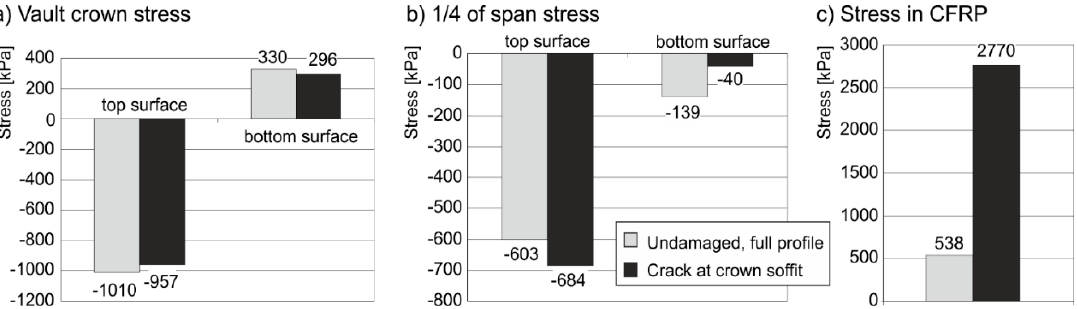
Figure 15. ( a ) Stress comparison at the reinforced vault crown with and without the initial crack; ( b ) Stress comparison at the reinforced vault 1/4 of span with and without the initial crack; ( c ) Stress comparison at the CRFP reinforcement with and without the initial crack.